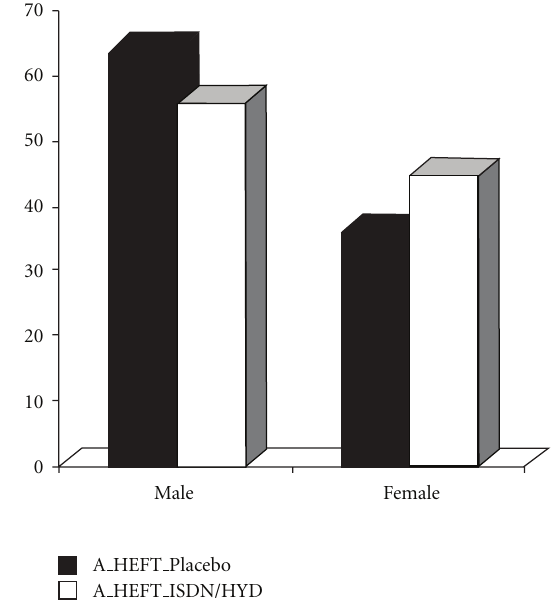
Figure 2: A-HEFT % of black participants in di ff erent intervention arms